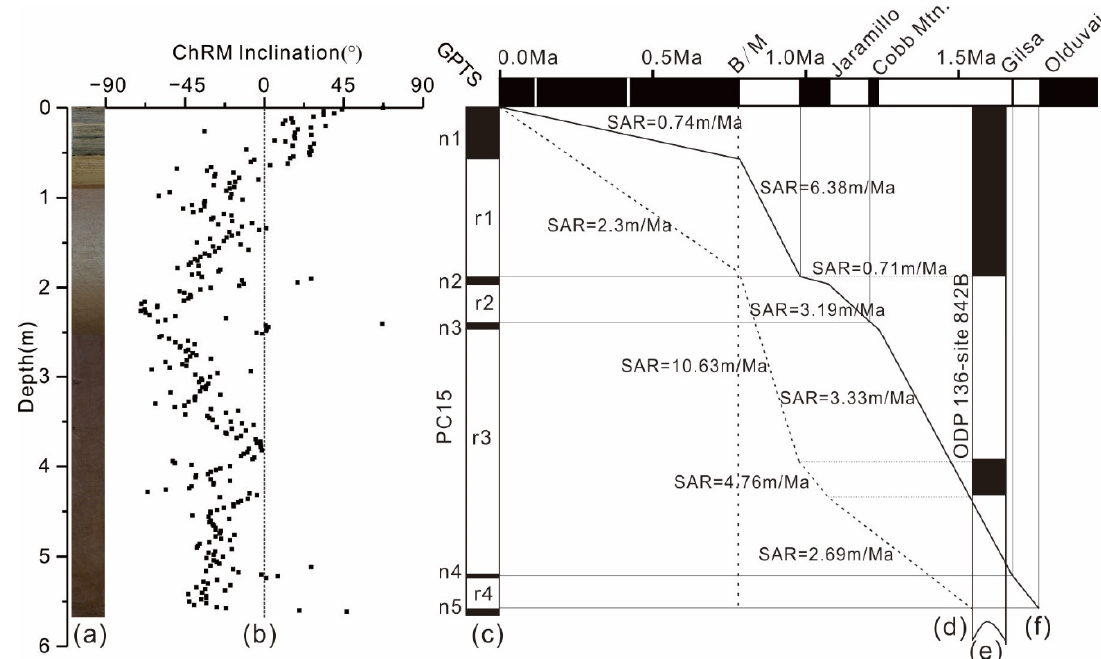
Figure 3. Orthogonal diagrams of the stepwise AF demagnetization of representative samples. Open triangles represent the horizontal planes, while solid squares represent vertical planes.